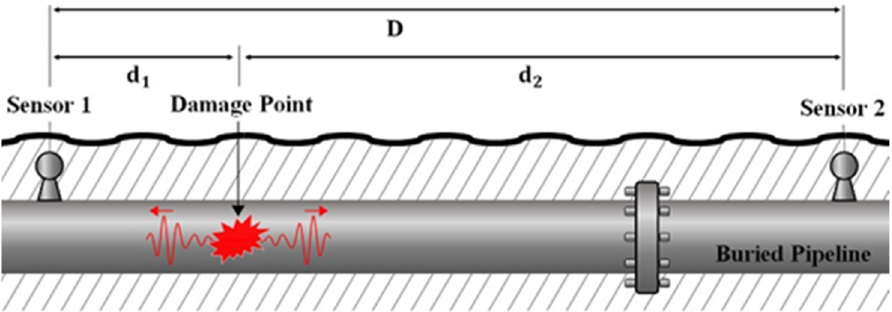
Figure 1. Source location in a buried pipeline with two sensors.